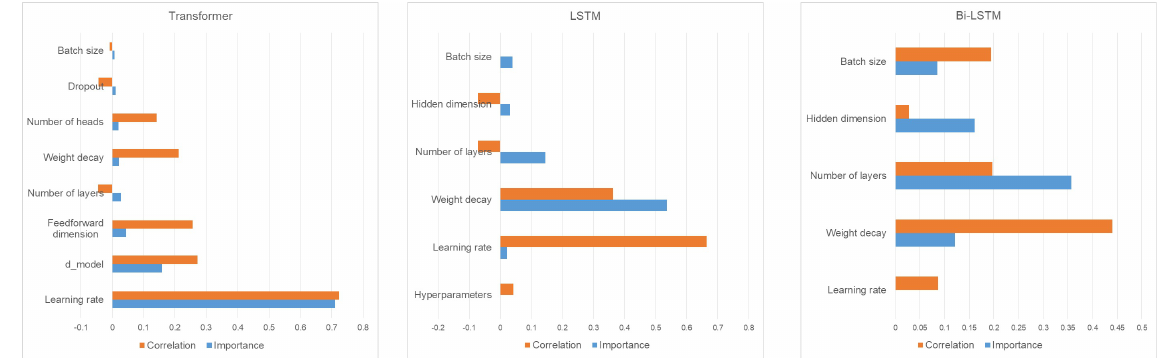
Figure 6. Hyperparameters importance with respect to the validation